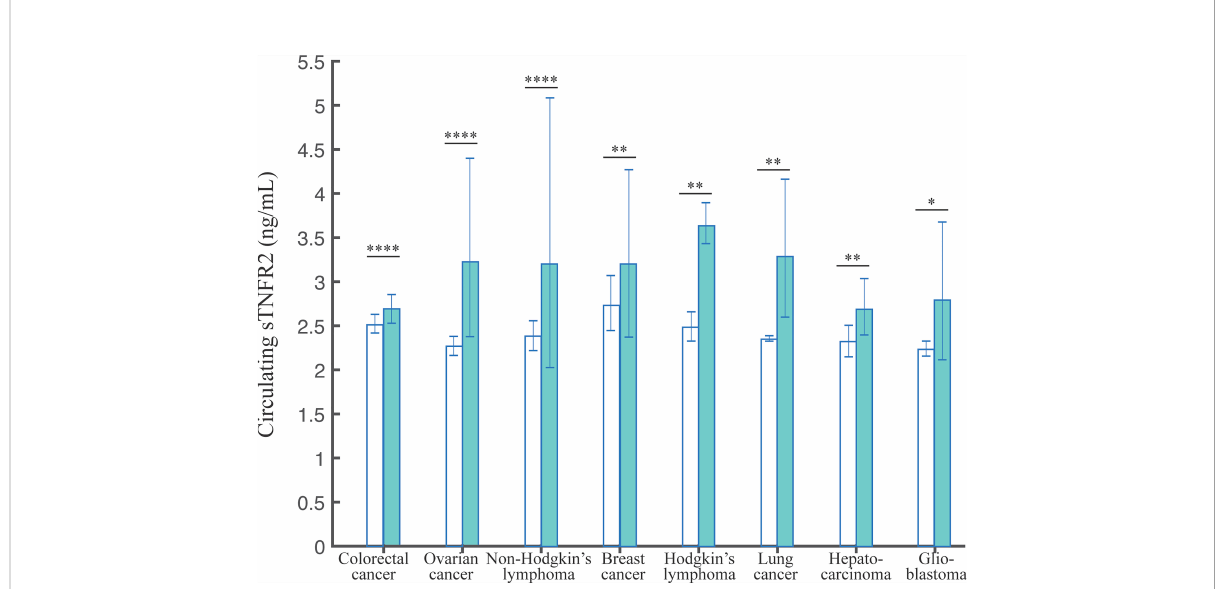
FIGURE 2 The pooled weighted means +/- 95% CI of sTNFR2 levels in serum/plasma from patients with the indicated cancers. The Tukey test was used to assess the signi fi cant difference of sTNFR2 levels, with *, **, and **** indicate P-values of <0.05, <0.01, <0.0001.